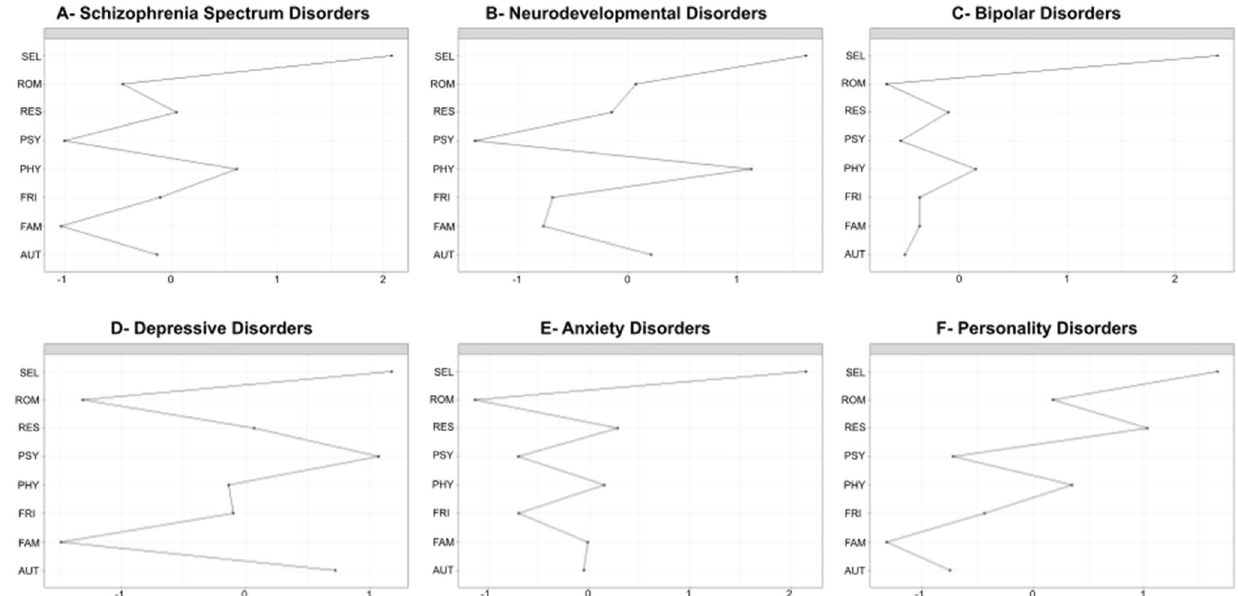
Figure 2. Centrality indices (node strength) of the eight quality of life dimensions obtained for the six diagnosis groups. For each diagnosis group ( A – F ), each node strength is shown as a standardized z-score (X axis). Quality of life dimensions (Y axis): SEL self-esteem, ROM romantic life, RES resilience, PSY psychological well-being, PHY physical well-being, FRI relationships with friends, FAM family relationships, AUT